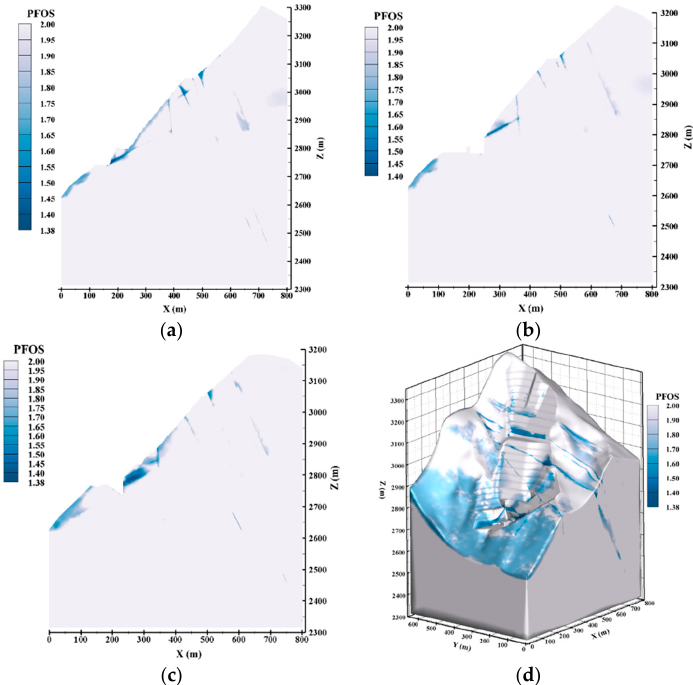
Figure 9. Point factor of safety distribution of slope under condition II. ( a ) Profile 5; ( b ) profile 10; ( c ) profile 13; ( d ) entire body. ( c ) profile 13; ( d ) entire